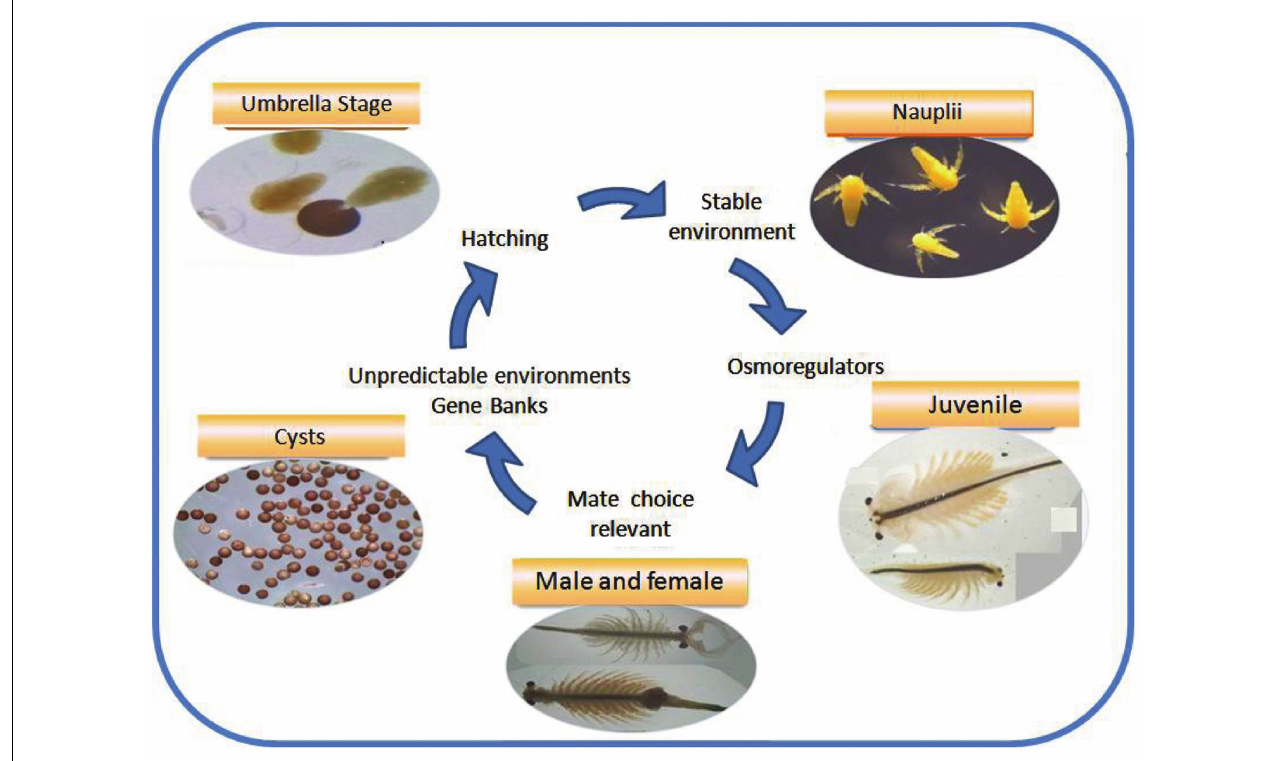
FIGURE 1 |The life cycle of a salty survivor: the extremophile Artemia. Different stages of the cycle are actively involved in survival and reproduction under critical environmental conditions.